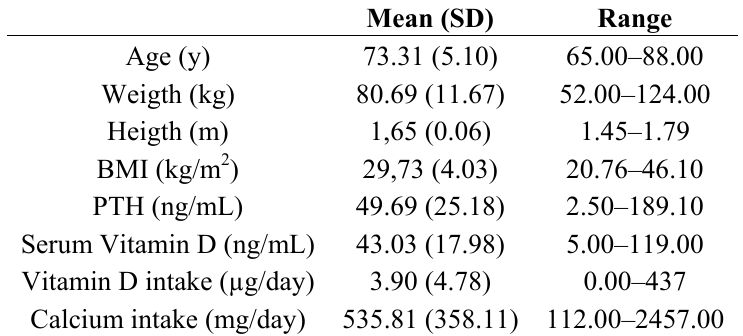
Table 1. Anthropometric, biochemical and nutrient intake data in the studied simple.